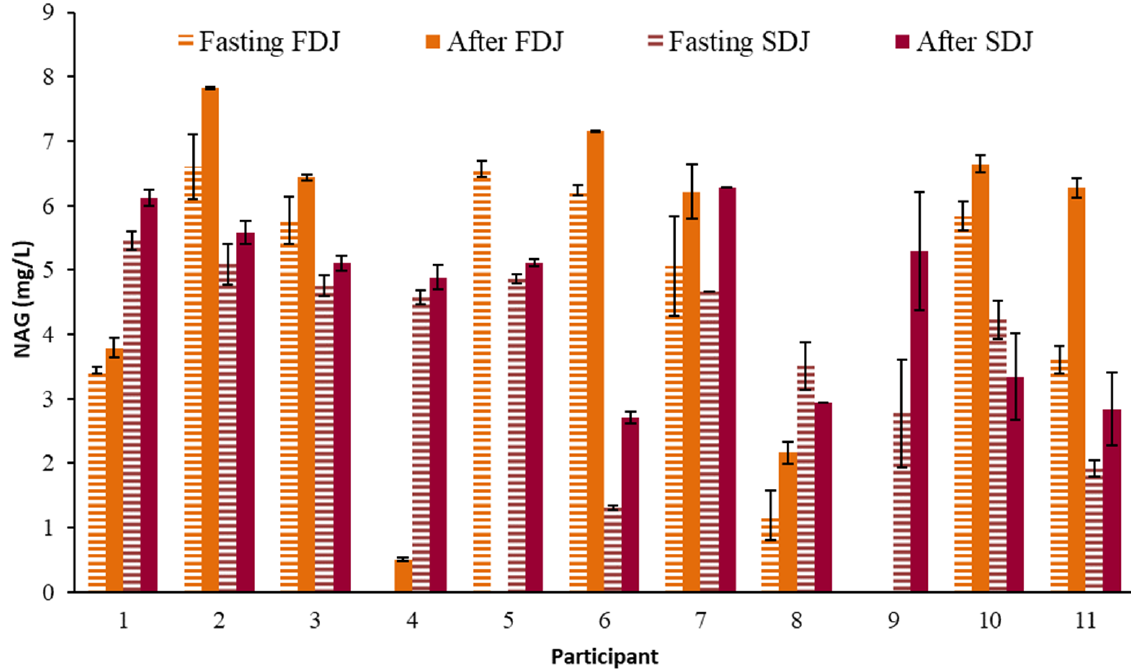
Figure 4. Mean value and standard deviation of serum blood naringenin (NAG) concentration analyzed in the participants on the days of consuming reconstituted freeze-dried (FDJ) and spray-dried (SDJ) juices, both fasting and 4 h after the intake of each juice.